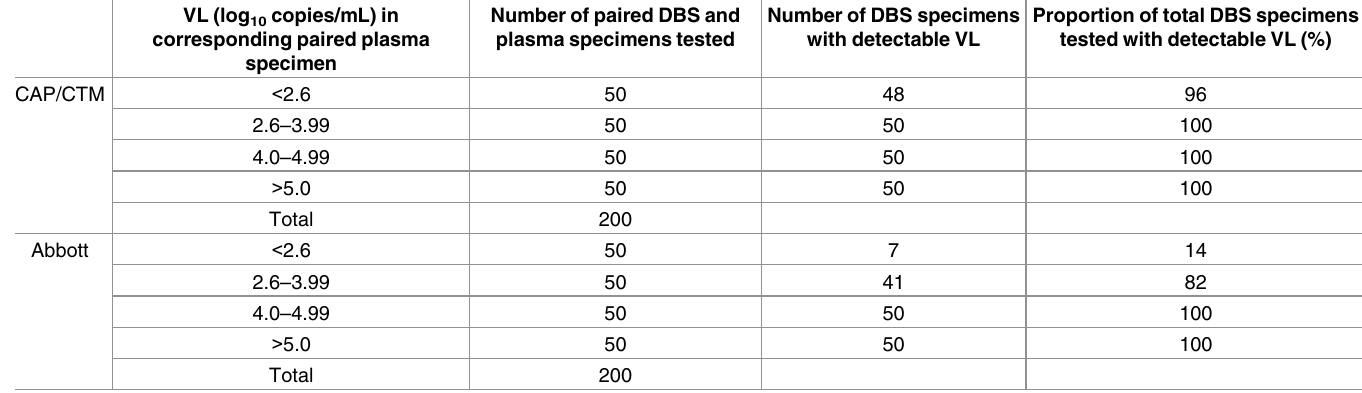
Table 1. HIV-1 RNA detection rates of dried blood spot (DBS) specimens paired with plasma specimens prepared from patient support centersin Nyanza, Kenya. (November2012 to February 2013). VL (log 10 copies/mL) in corresponding paired